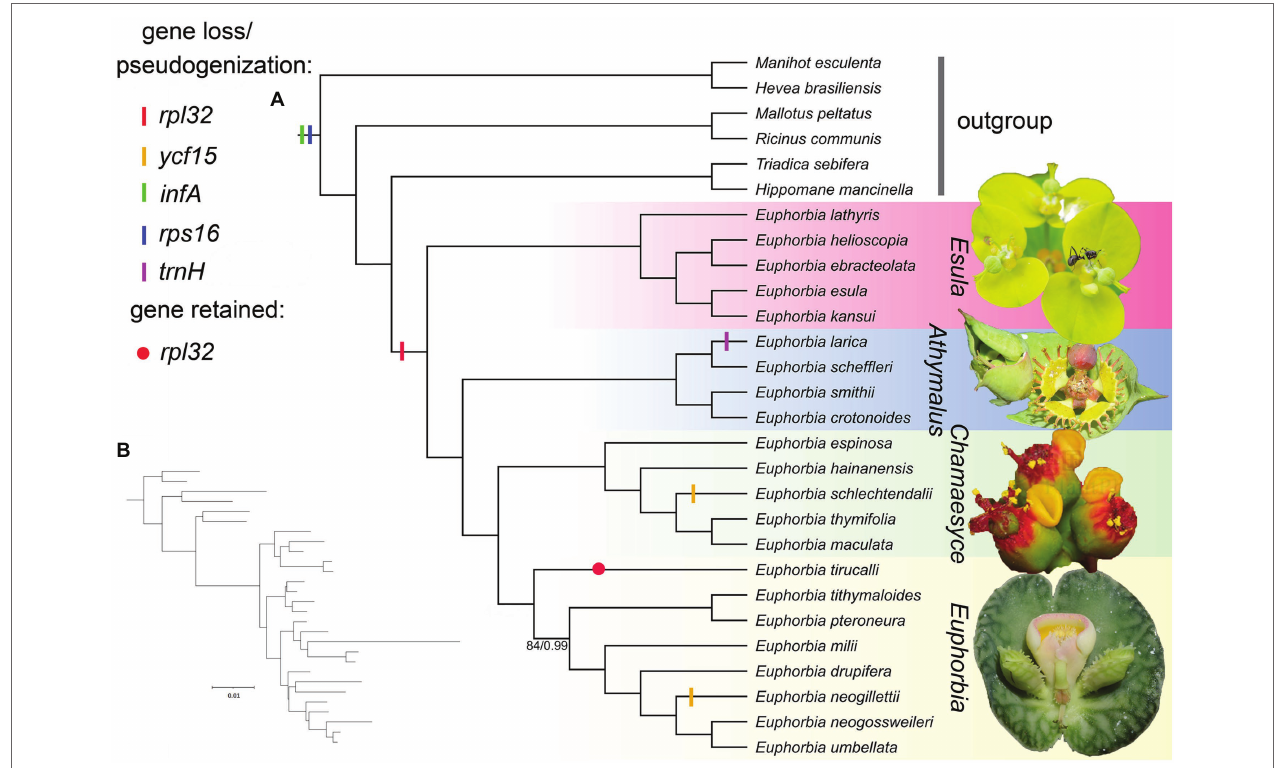
FIGURE 7 | (A) Cladogram of maximum likelihood (ML) tree of Euphorbiaceae reconstructed from 76 plastid coding sequences (CDSs), showing the gene losses/ pseudogenizations in the framework of representatives of Euphorbiaceae. Numbers below the branches are ML bootstrap values (BS)/Bayesian inference (BI) posterior probabilities (PP). All branches were supported as BS = 100/PP = 1.0 unless otherwise shown. Photographs (from top to bottom) are cyathia of Euphorbia sikkimensis , Euphorbia grantii , Euphorbia pulcherrima , and Euphorbia echinulata , respectively. Five species in subg. Chamaesyce were included in the previously segregate genus Chamaesyce , whereas E. umbellata , E. neogillettii , E. tithymaloides , Euphorbia neogossweileri , and Euphorbia drupifera represent the previously segregated genus Synadenium , Monadenium , Pedilanthus , Endadenium , and Elaeophorbia , respectively. (B) Phylogram of ML tree shown in (A) , showing branch lengths proportional to nucleotide substitutions per site. Photo credit: Neng